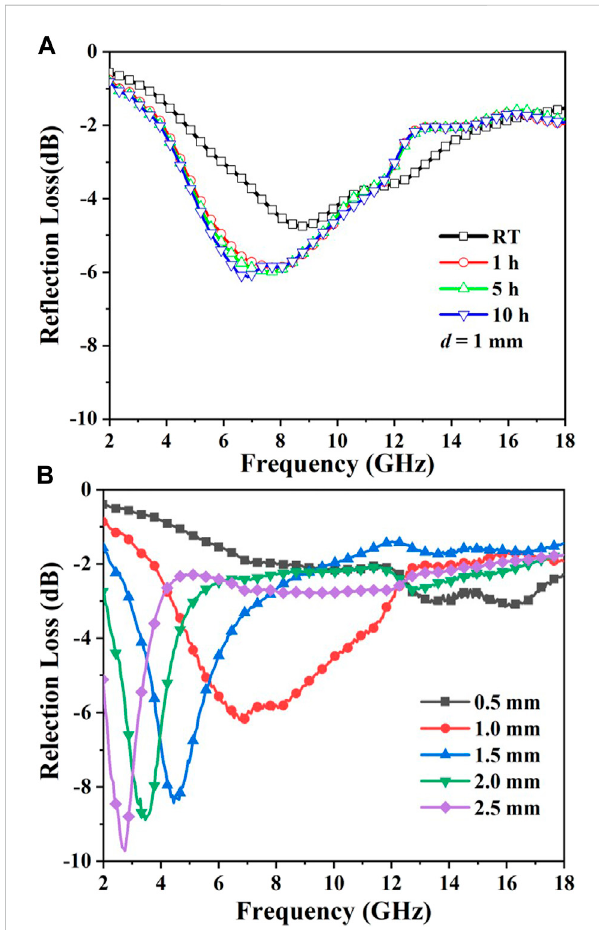
FIGURE 7 Simulated re fl ection loss of FeCoCr/silicone resin coating (A) after heat treatment at 400 ° C for different time and (B) with different thickness after heat treatment at 400 ° C for 10